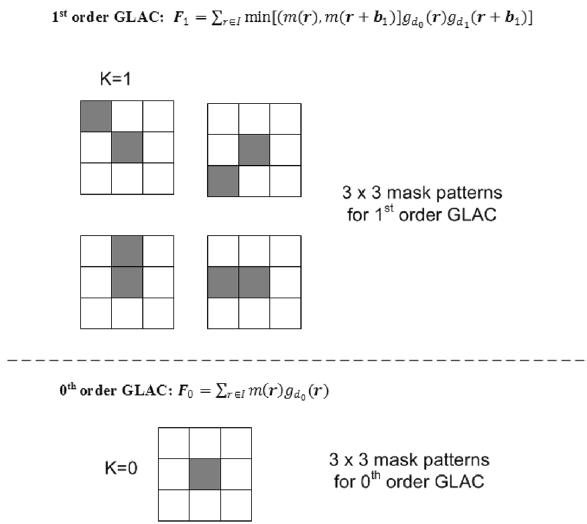
Fig. 5 Mask patterns for the 0th and 1st order auto-correlation